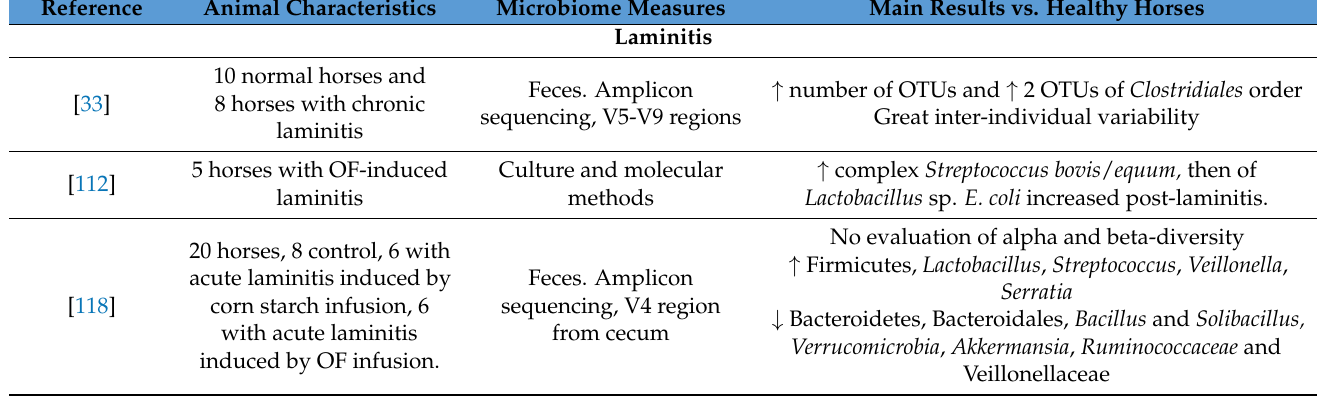
Main microbiota changes (alpha and beta diversity, taxonomic composition)